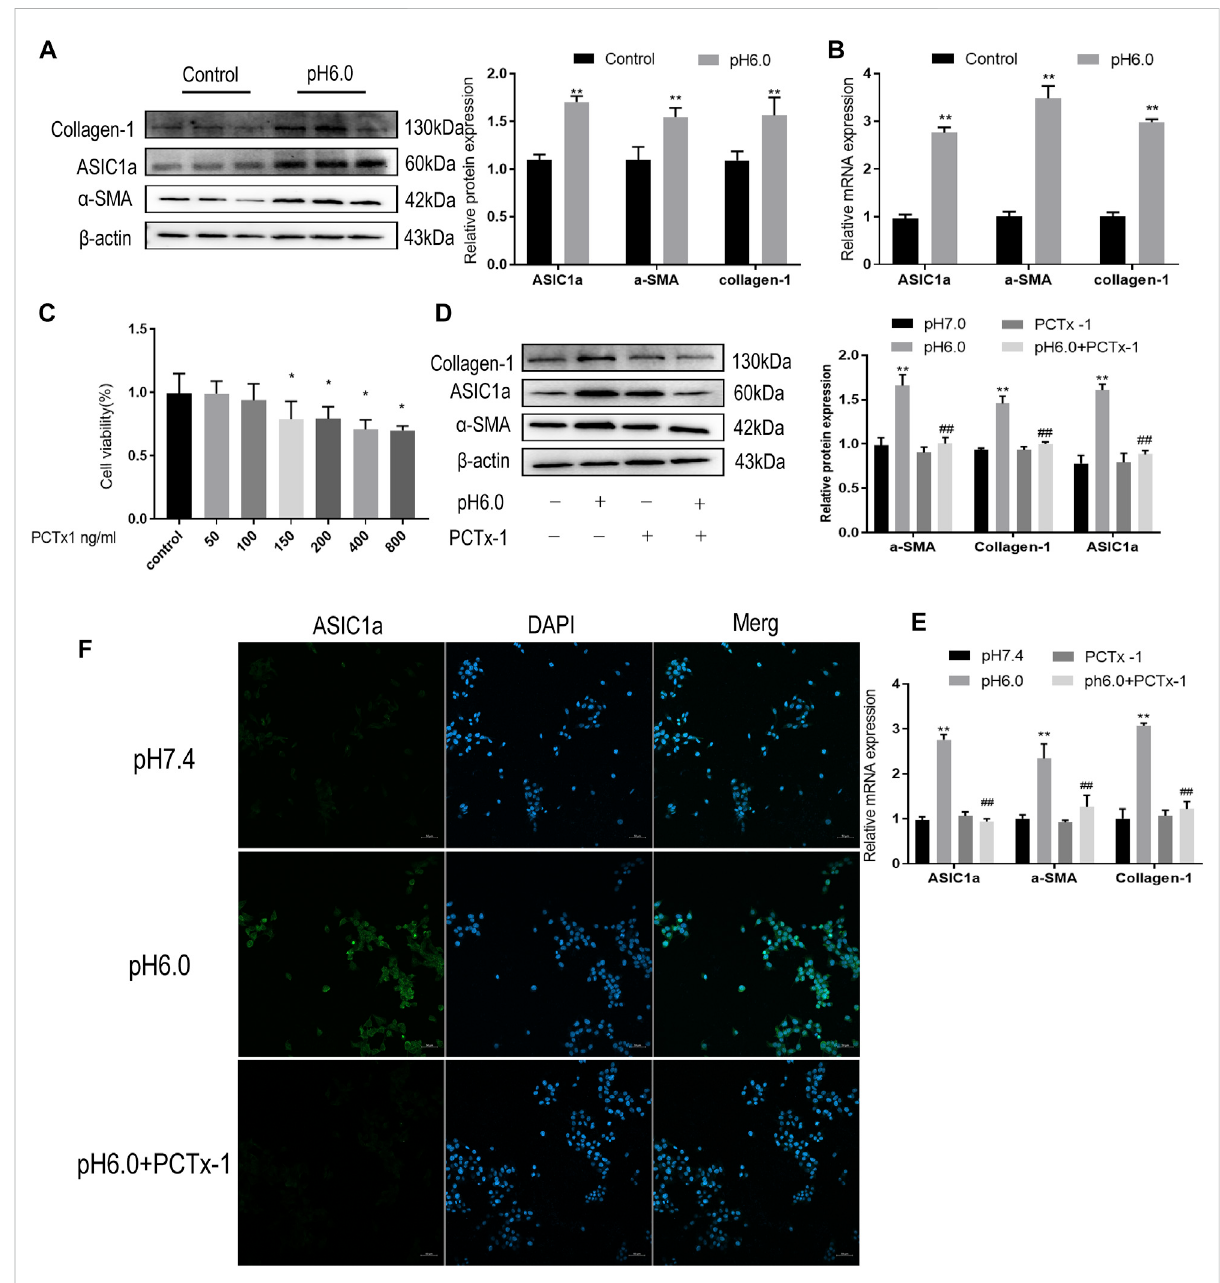
Inhibition of ASIC1a improves acid-induced activation of HSCs. (A) Western blotting was used to detect the expression of collagen-1, ASIC1a and α -SMA in HSCs stimulated by pH 6.0. (B) qRT-PCR was used to detect the mRNA levels of collagen-1, ASIC1a, and α -SMA in HSCs stimulated by pH6.0. (C) TheeffectofPcTx-1ontheviabilityofHSCswasdetectedbyCCK8. (D) Westernblottingwasusedtodetecttheexpressionofcollagen-1, α -SMA,andASIC1ainHSCsundertheinterventionofPcTx-1. (E) qRT-PCRtodetecttheexpressionofcollagen-1,ASIC1a,and α -SMAunderthe intervention of PcTx-1. (F) Immuno fl uorescence to detect the effect of PcTx-1, a speci fi c blocker of ASIC1a channel, on ASIC1a in HSCs. (Scale Bar, 50 μ M). Data are expressed as the mean ± SD ( n ≥ 3). * p < .05, ** p < .01 vs. Control group; # p < .05, ## p < .01 vs. pH 6.0